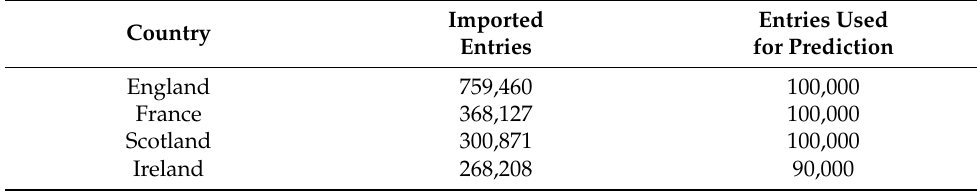
Table 8. Imported versus analysed entries. Country